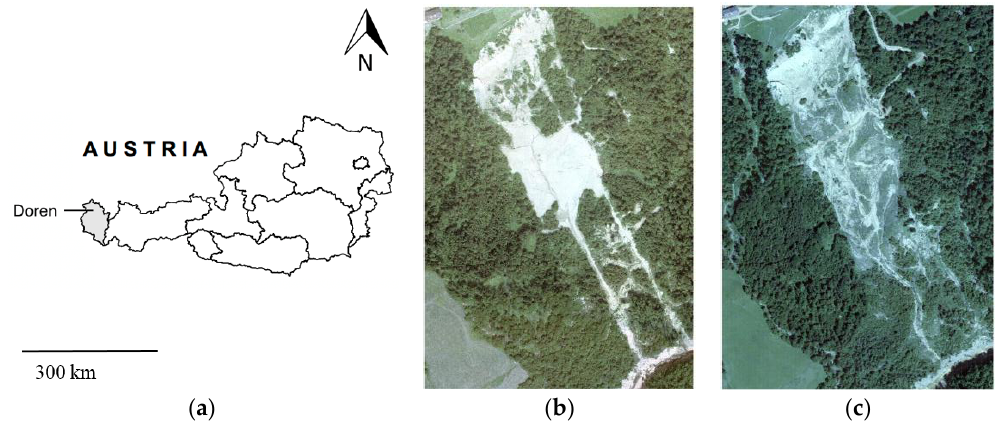
Figure 1. ( a ) In grey the location of Vorarlberg in western Austria with the Doren landslide (47°29′21.38″N, 9°53′1.59″E); ( b ) Orthophoto of the study area for 2006; ( c ) Orthophoto of the study area for 2012. Study area is 800 m × 478 m.